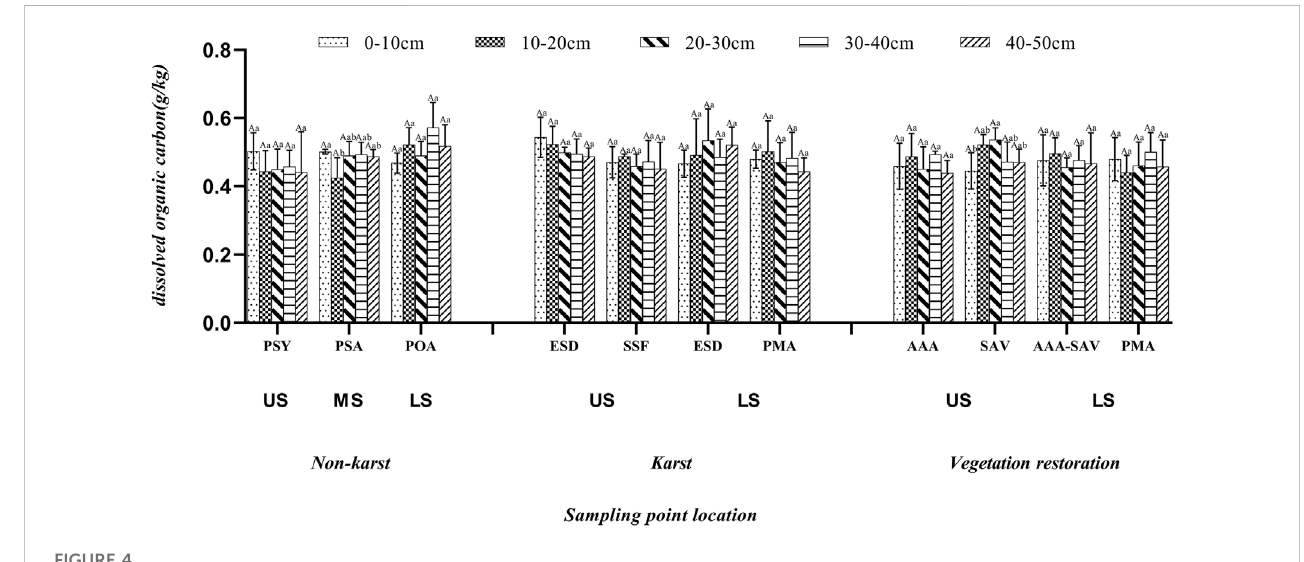
FIGURE 4 Content distribution characteristics of DOC in different bands.